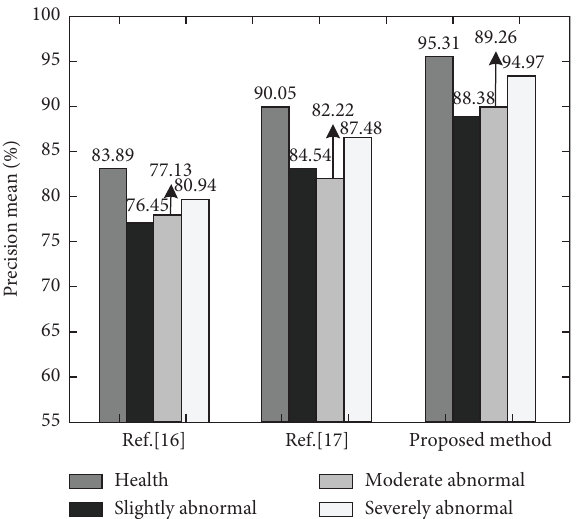
Figure 10: Evaluation results of diferent methods for each state.